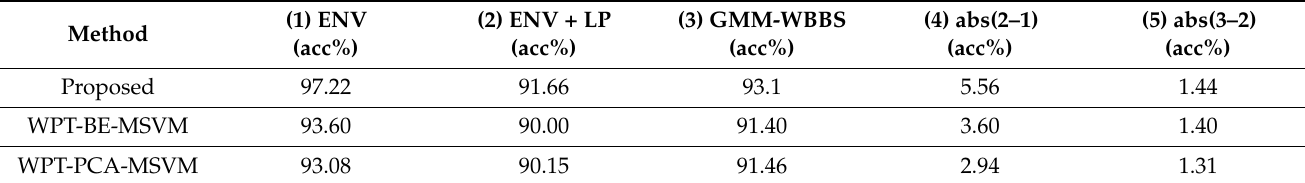
Table 10. Classification accuracy